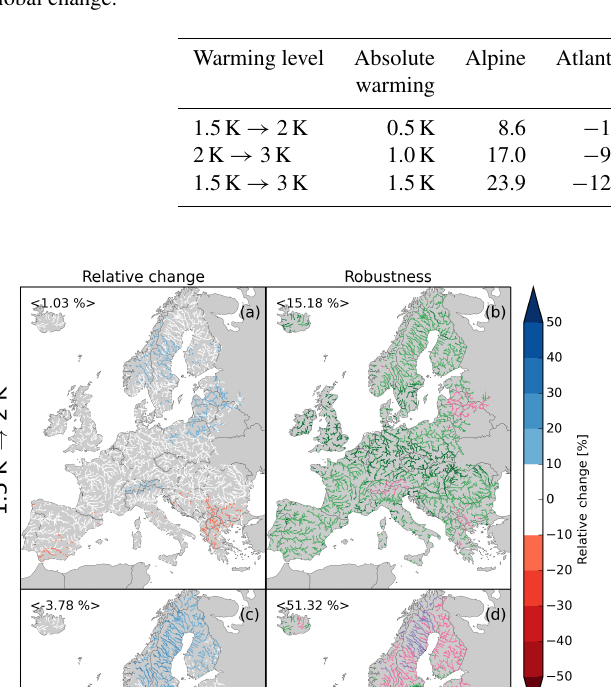
Table 3. Relative changes averaged over regions (%) in multi-model ensemble mean low-flow indicator (Q90) between different levels of global change.